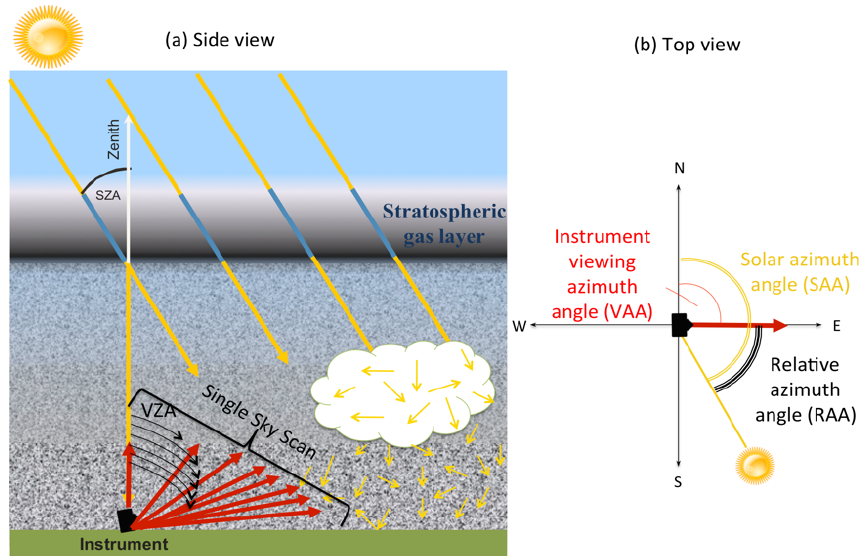
Figure 4. Demonstration of the MAX-DOAS principle: (a) side view and (b) top view. Simplified photon paths through the atmosphere are shown in yellow. A single sky scan sequence for profile retrieval consists of multiple viewing zenith angles (VZAs) in a specific direction (viewing azimuth angle, VAA) at a specific solar zenith angle (SZA) and is shown in